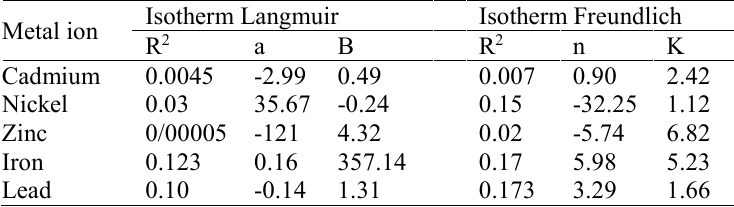
Table 1. Results of fitting langmuir and freundlich models for natural dolomite and each heavy